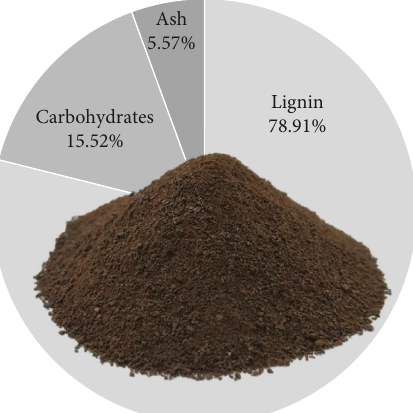
Figure 1: The physic and composition of rice straw